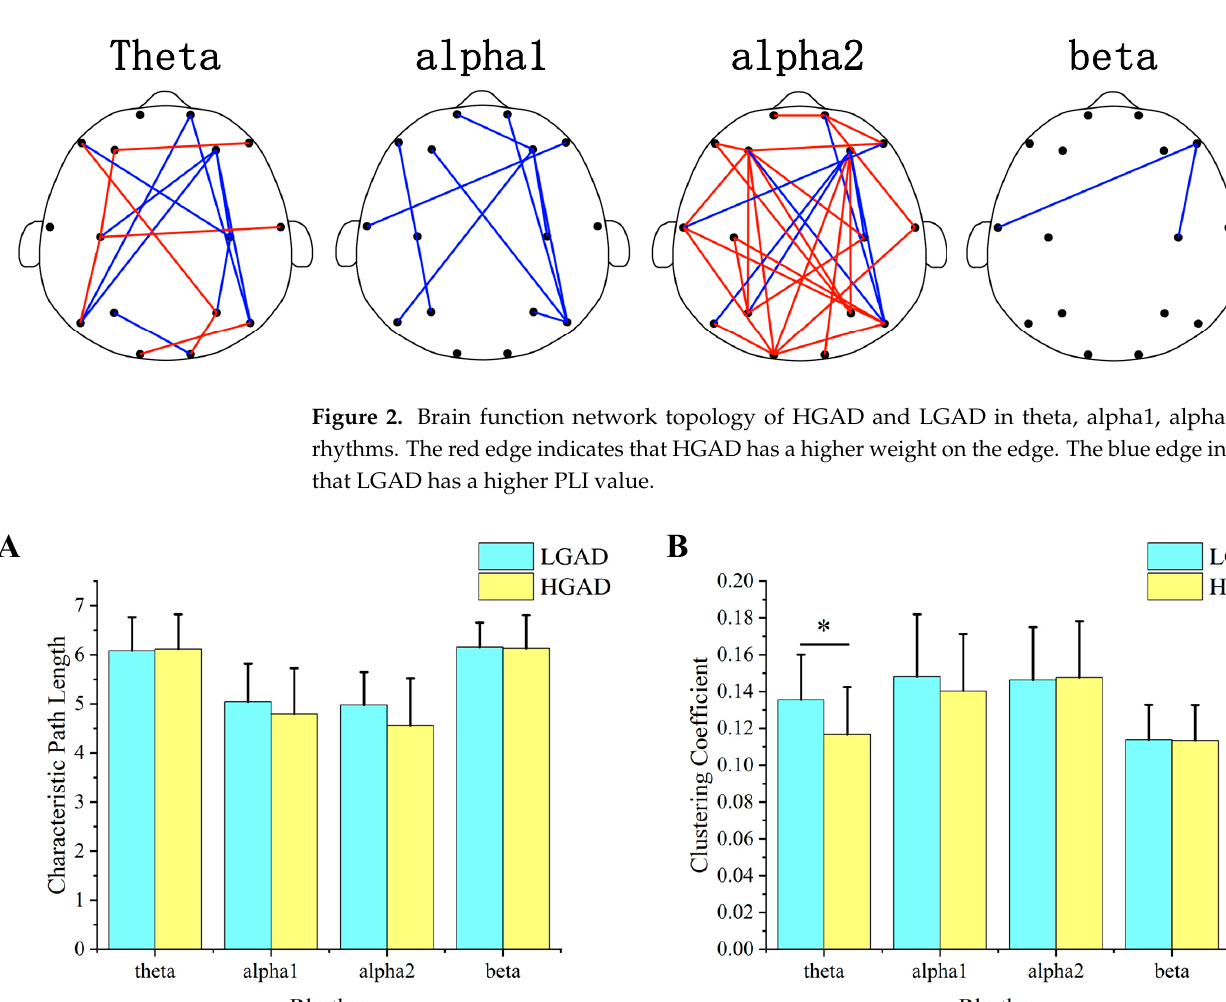
Figure 3. The results of network features for all EEG rhythms between LGAD and HGAD. ( A ) Characteristic path length. ( B ) Clustering coefficient. The column represents the size of the value, and * represents the statistical difference between the two groups of characteristic values at this position ( p < 0.05).